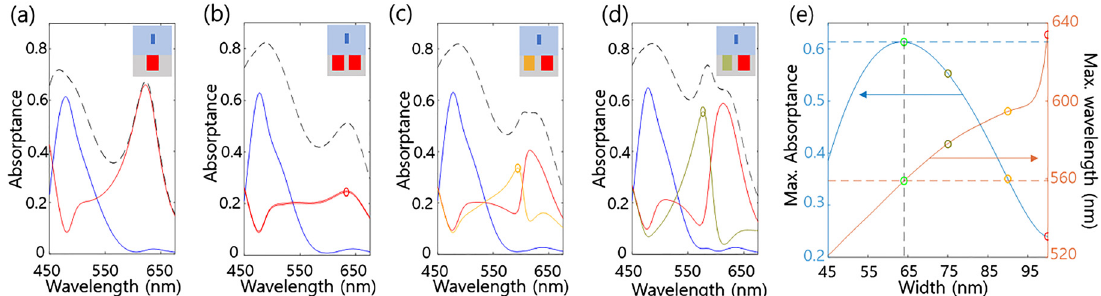
Figure 3: The evolved abilities of three-color sorting in integrated metasurfaces with varying width of added nanobeams. (a)Metasurfacescomposedbytwodifferenttypesofnanobeamarrays( w L =100nm, d L =130nm, w S =10nm, d S =80nm, P =300nm)tohave coherent interactions in vertical directions. (b) The absorptions with the increased density of bottom nanobeams. The magnitude of absorption decreases and the spectrum is signi fi cantly broadened due to the overcoupling of incident light. (c,d) The creation of additional, detectingchannelsbythereducedwidthofaddednanobeamsas90nm(c)and75nm(d).Theabsorptionspectrumsaresplitandblue-shifted from panel (b) as the width of the nanobeams decreases, and the magnitude of absorption is enhanced by the destructive interference of scatteredlight from the array of two different-sizednanobeams at the bottom layer. The circlemarks indicatethe wavelength of the maximum light absorption in added nanobeams. Black dotted line is the total absorption in metasurfaces. (e) Magnitude of maximum absorption (blue line) and the corresponding wavelength (orange line) of the added nanobeam array as the width varies from 45 to 100 nm. The optimal condition for the sorting of full-color is indicated as green circular